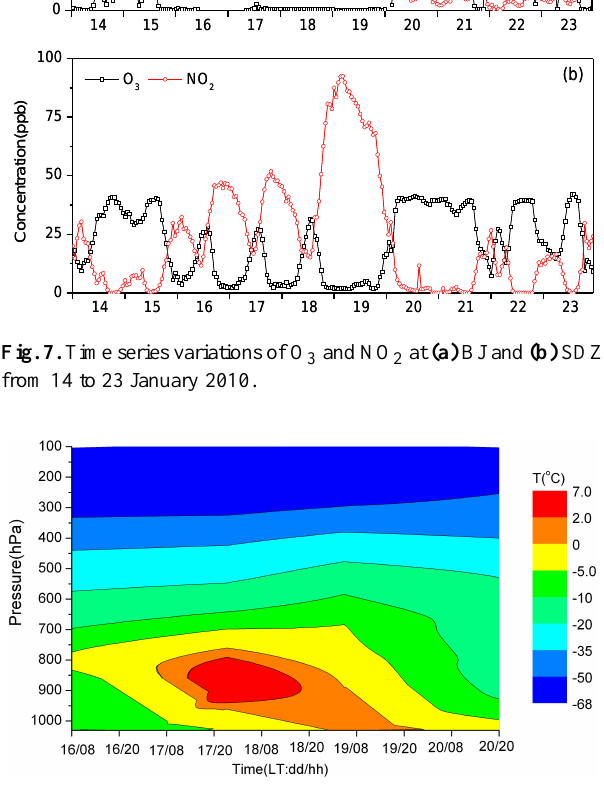
Fig. 8. Variation of temperature in vertical direction from 16 to 20